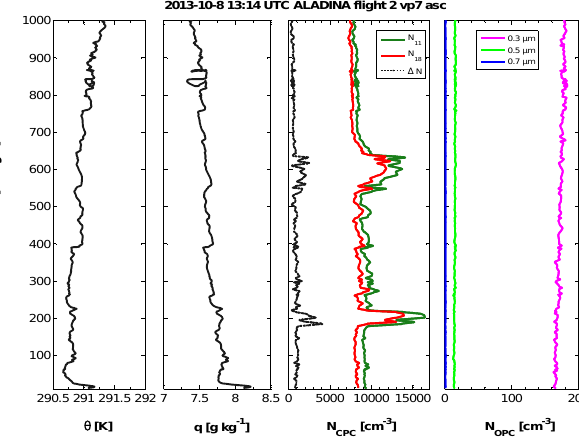
Figure 14. Vertical profiles of (a) potential temperature θ , (b) water vapour mixing ratio q , (c) aerosol number concentrations for parti- cle sizes above 11nm ( N 11 , green line), detected with the CPC1 and aerosol number concentrations for particles above 18nm ( N 18 , red line) measured with the CPC2; the difference of both CPCs ( (cid:49)N , black dots) and (d) particle number concentrations for particle sizes above 300nm (pink line), 500nm (bright green line) and 700nm (blue line) detected with three OPC channels during flight 2 (as- cent) in Melpitz on 8 October 2013 at 13:14 UTC.